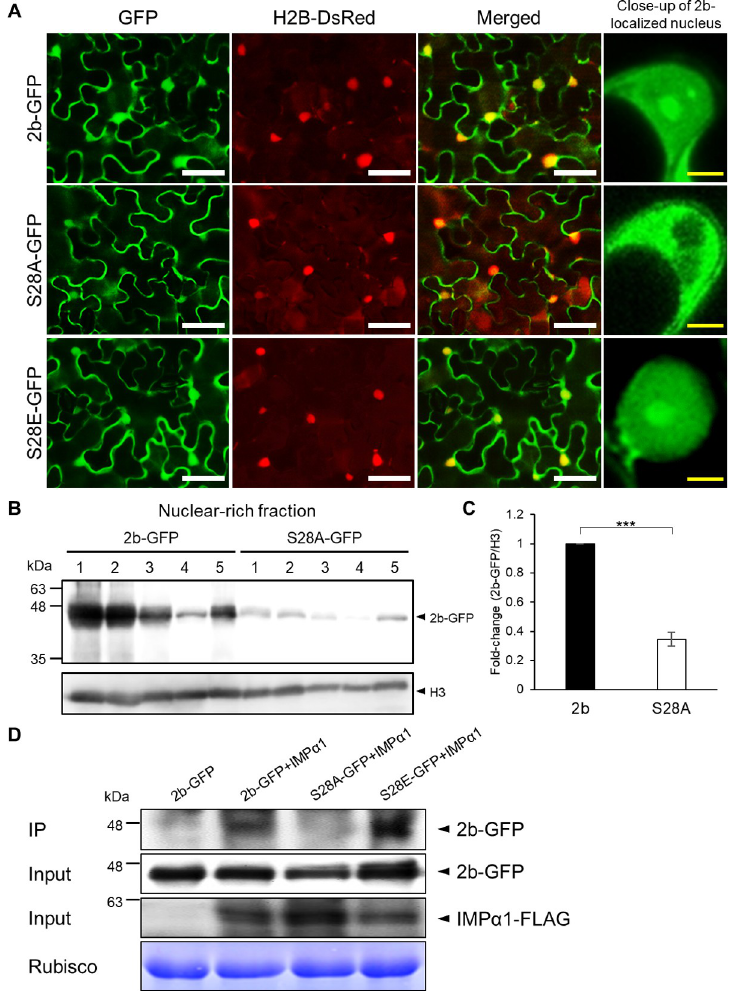
Fig 3. Effect of S28 phosphorylation on subcellular localization of 2b. (A) Subcellular localization of 2b and the 2b mutants in N . benthamiana cells. 2b-GFP and the GFP-tagged 2b mutants (S28A-GFP and S28E-GFP) were co- expressed with H2B-DsRed in agroinfiltrated leaves. GFP fluorescence was observed at 2 days post agroinfiltration using a confocal microscope. Scale bar: 50 μ m (white) or 5 μ m (yellow). (B) Detection of 2b and S28A in the nuclear- rich fraction. 2b-GFP and S28A-GFP were overexpressed in agroinfiltrated leaves, and the nuclear-rich fraction was probed for the proteins in a western blot. The GFP-tagged proteins and H3 (the loading control) were detected using anti-GFP antibodies and anti-H3 antibodies, respectively. The numbers above the blot are 5 replicate leaves; identical numbers indicate the same leaves were used for 2b-GFP and S28A-GFP. (C) Relative 2b accumulation levels. The relative 2b-GFP/H3 ratios were densitometrically calculated using Multi Gauge Software and shown as a fold-change. Mean values ( ± SE) were tested on log-transformed data for a significant difference using Student’s t -test ( ��� P < 0.001). (D) In vivo co-immunoprecipitation of NbIMP α 1 and 2b-GFP. NbIMP α 1/2b-GFP complexes were first co-precipitated using anti-FLAG antibody, and 2b-GFP, S28A-GFP and S28E-GFP in the precipitant were detected by western blot analysis using anti-GFP antibodies. 2b-GFP, S28A-GFP, S28E-GFP and NbIMP α 1-FLAG in the total protein extracts are shown as the inputs. RuBisCo large subunit is shown as a loading